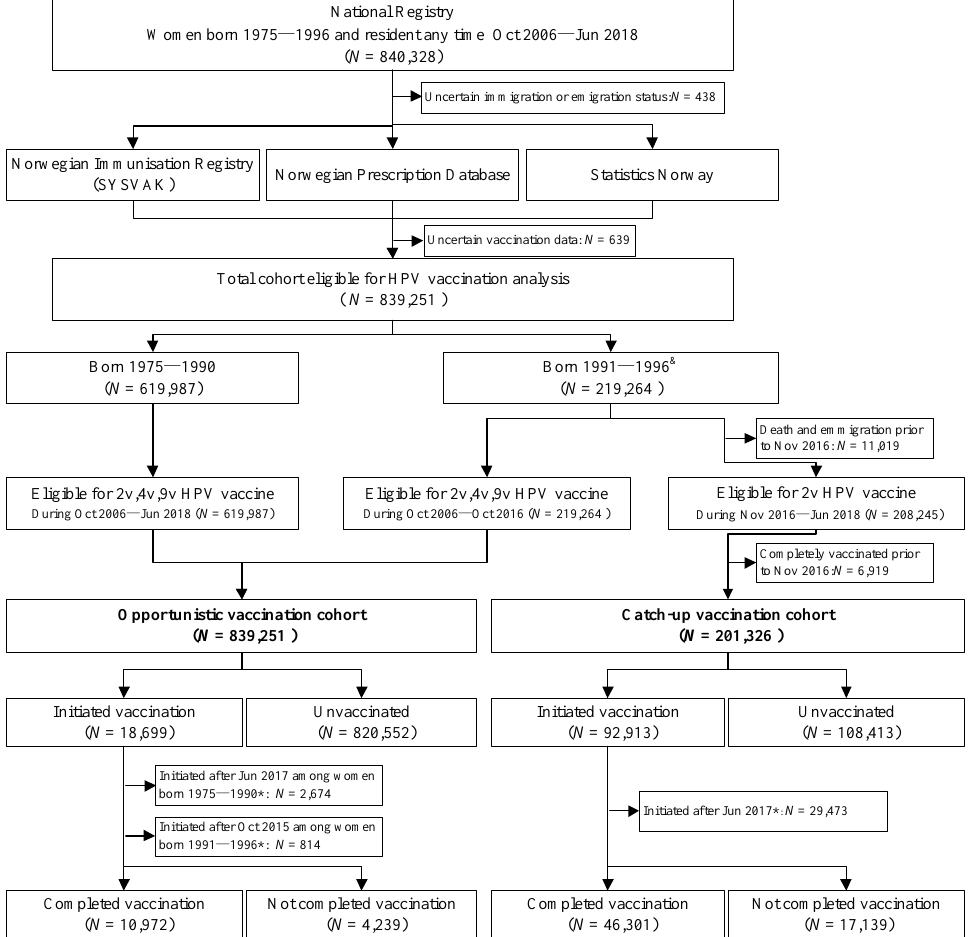
Figure 1. Data sources and study population for opportunistic and catch-up HPV vaccination. Abbreviations: PIN, personal identification number; HPV, human papillomavirus. & Women born from 1991 to 1996 were eligible for opportunistic vaccination until October 2016 and for the 2v catch-up vaccination program from November 2016; * Women who initiated after one year before the end of follow-up were excluded from completion analyses because their completion during one year could not be